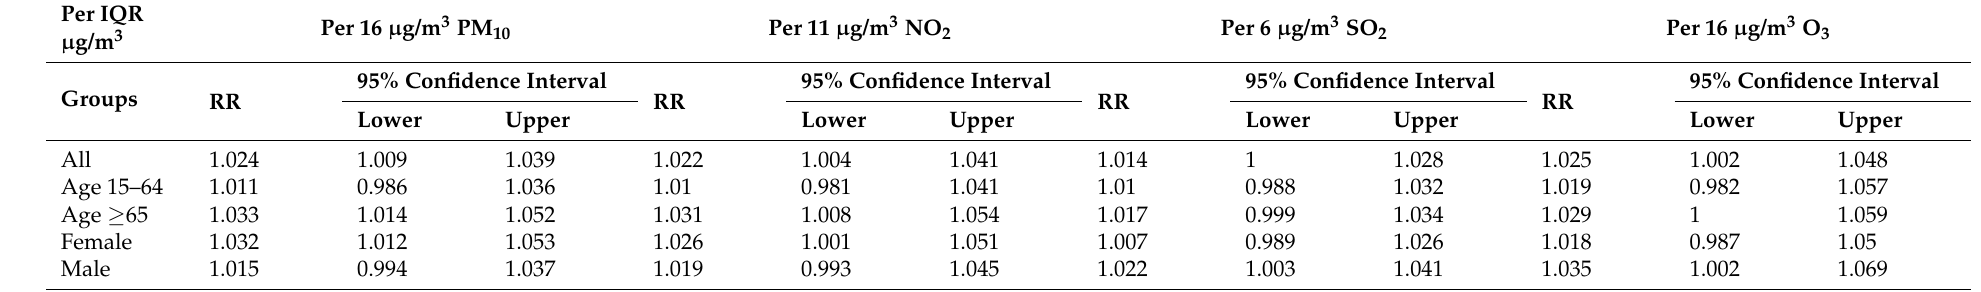
Table 3. Relative risk estimated from Quasi-Poisson regression models of cardiovascular and respiratory disease deaths, adjusting for time trends and seasonal variation, day of the week, public holiday, and meteorological factors including temperature and relative humidity. Estimates are presented per IQR increase in the two-day moving average (lag 0–1) of PM 10 , NO 2 , SO 2 and O 3 for all age and sex